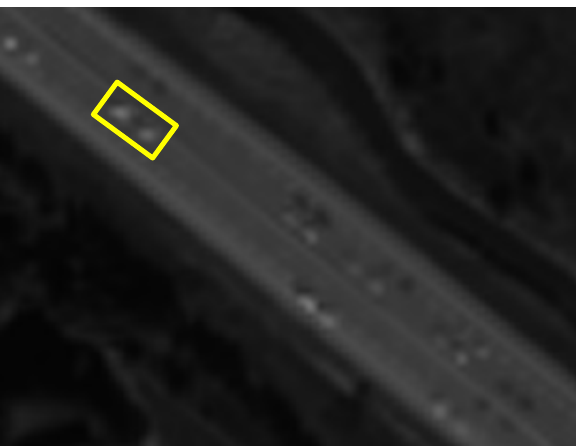
Figure 4: Second principal component of MS image (MS: PCA2). In this figure, two positions of the same vehicle are available.